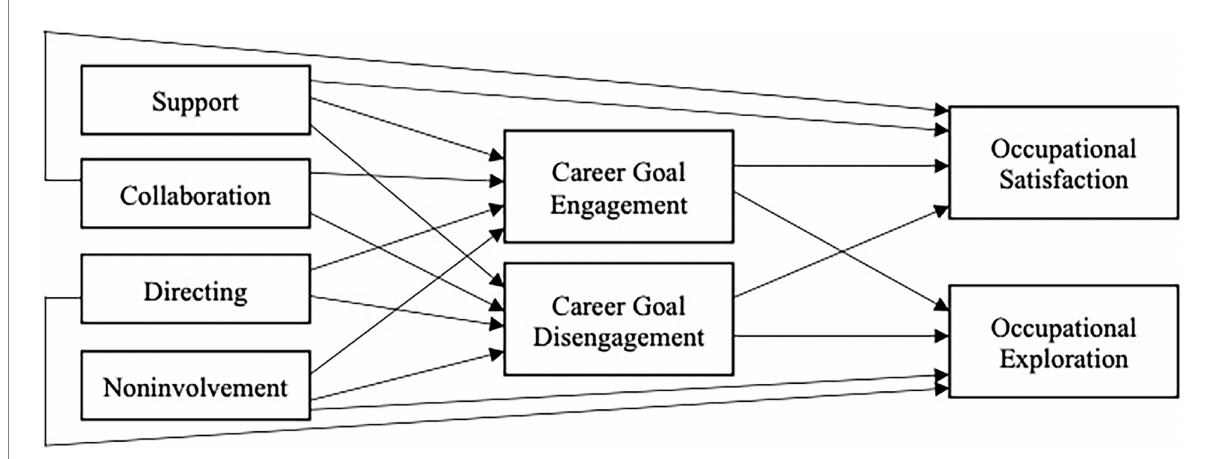
FIGURE 1 Mediation model depicting direct effects. Indirect effects are the effect of predictors (support, collaboration, directing, and noninvolvement) on outcomes (occupational satisfaction, and occupational exploration) via the mediators (career goal engagement, career goal disengagement). Total effects are the combination of direct and indirect effects. Covariances between predictors, between mediators, and between outcomes included in model but not depicted here. Age and gender included in model as covariates, but not depicted